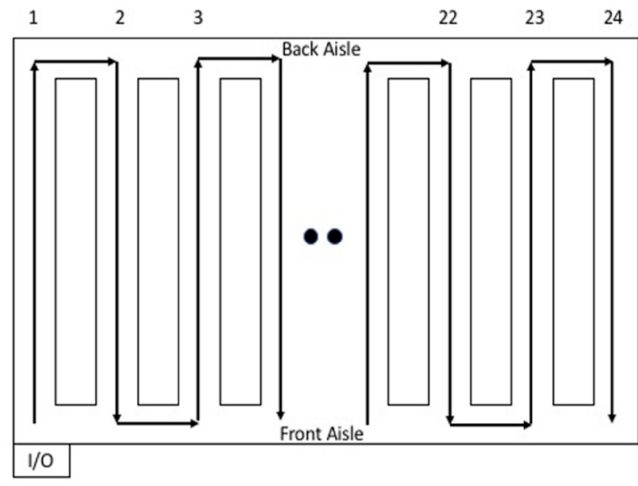
Figure 1. The distribution center under study follows an S-shape